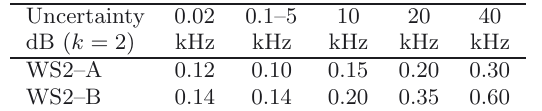
Table 4. Typical uncertainties of actuator response (A) and of free-field response (B) obtained by adding corrections. The reference frequency is 250 Hz.